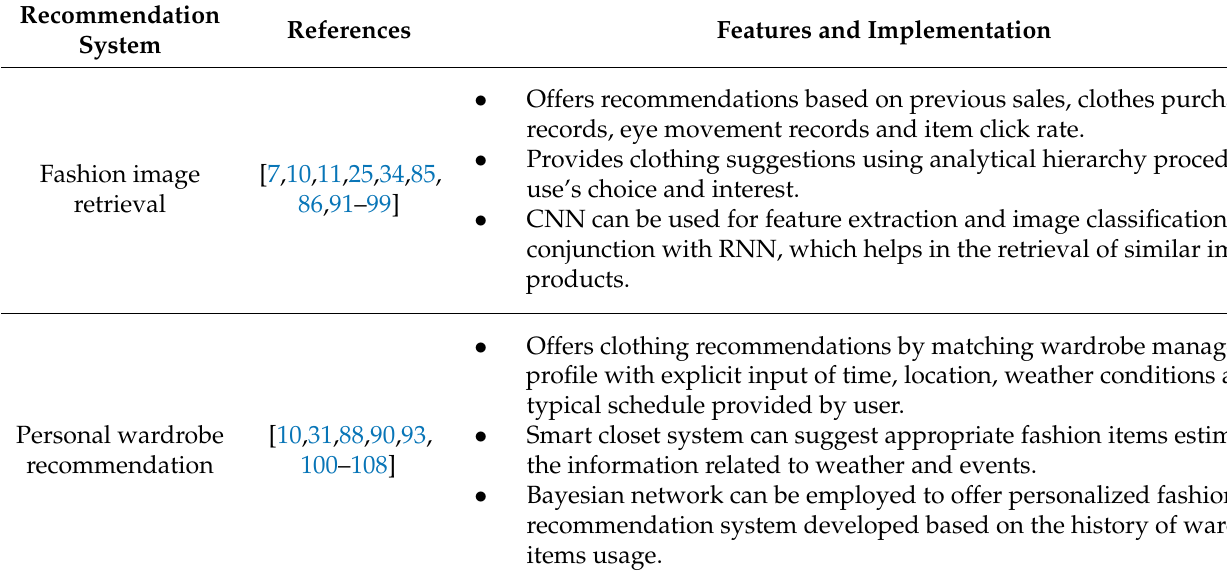
Table 2. Classification of fashion recommendation systems